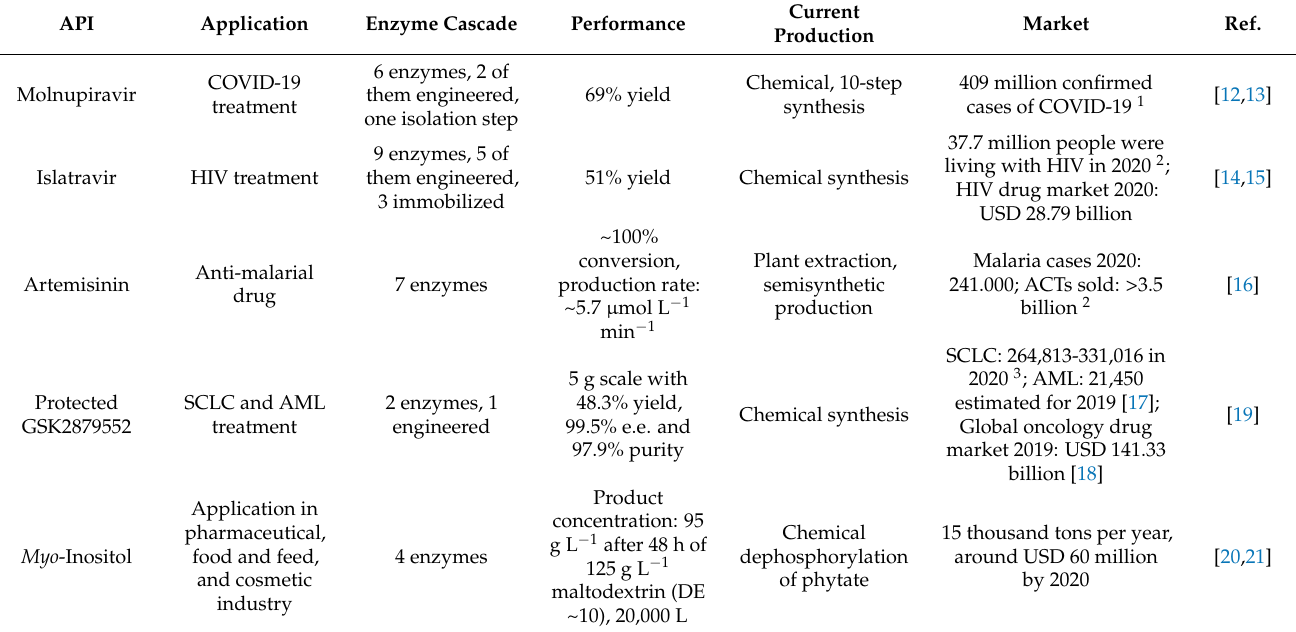
Table 1. Overview of APIs with enzyme cascades, their performance, current production, and their potential